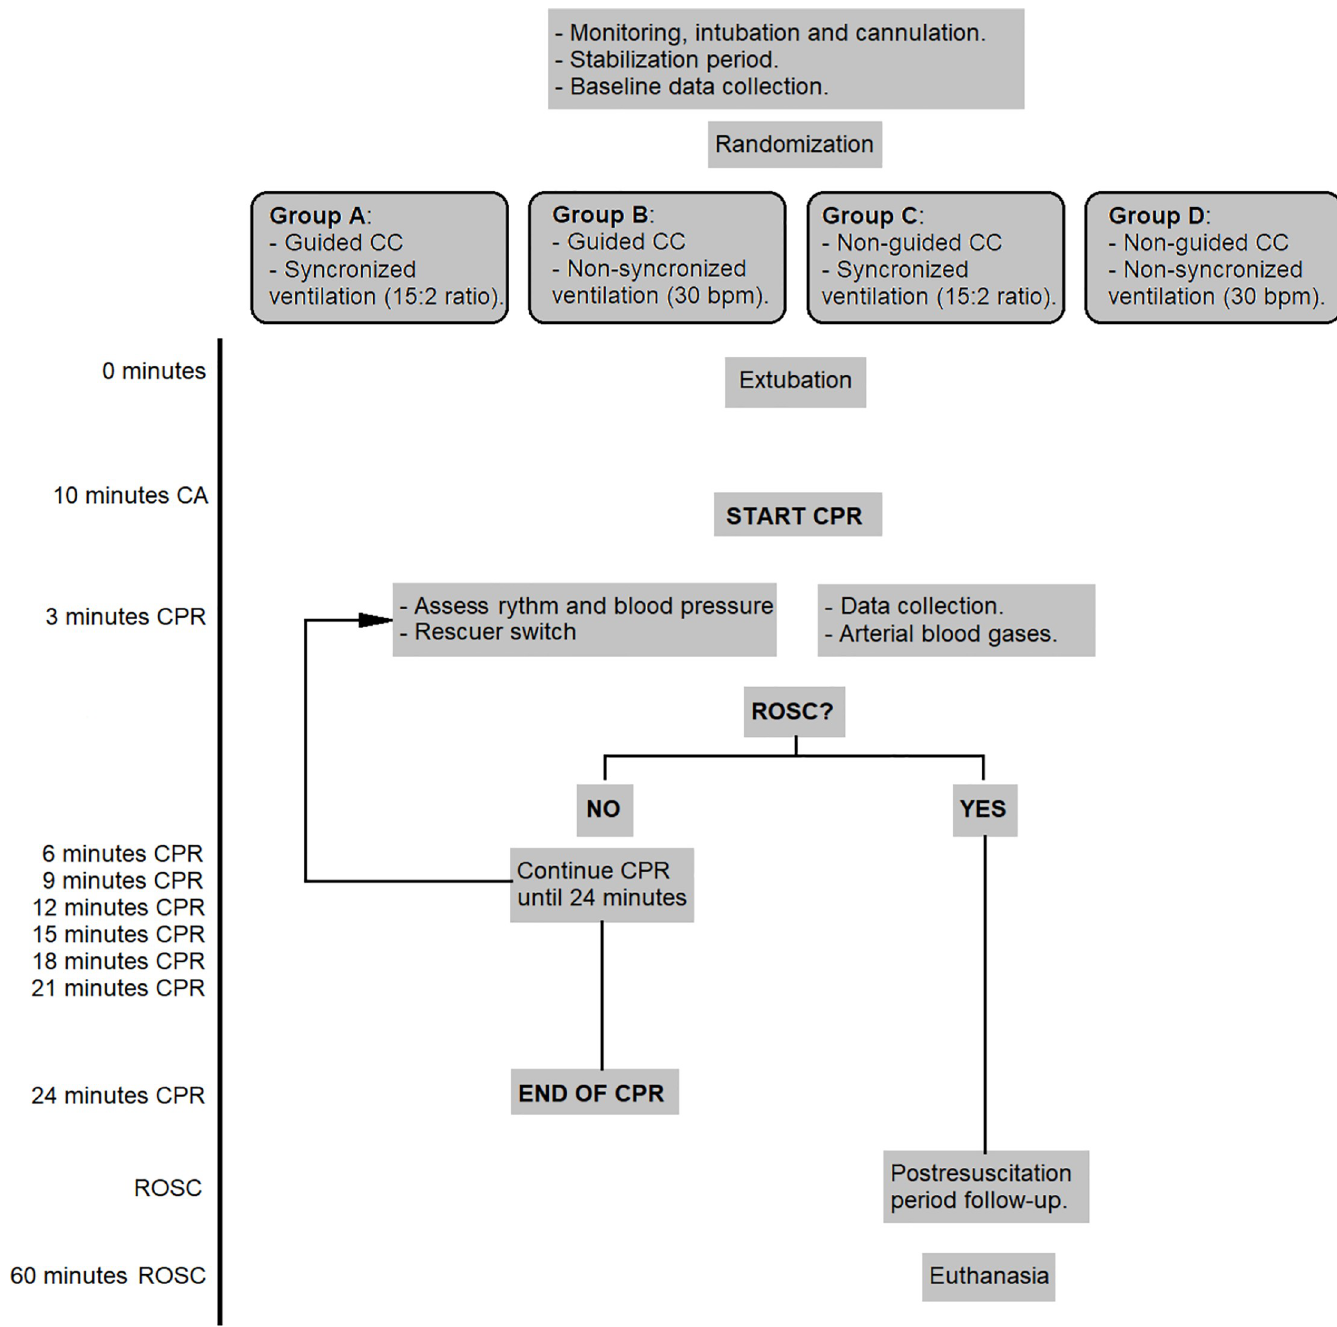
Fig 1. Brief summary of the